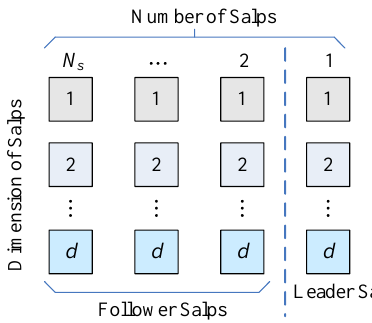
Figure 6. The structure of a salp swarm chain.